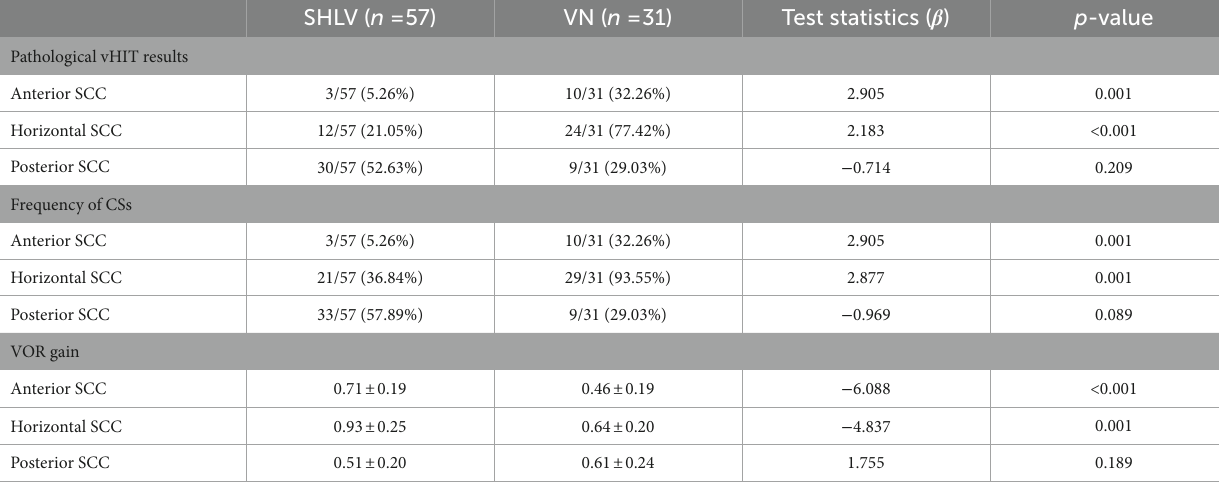
TABLE 2 Incidence of pathological vHIT results, frequency of CSs and VOR gain in three SCCs on the affected sides in patients with SHLV and